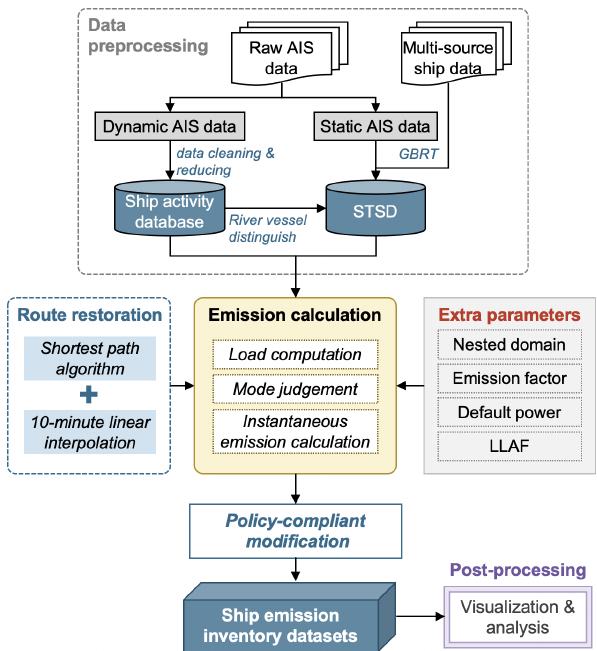
Figure 1. Structure and flow chart of the SEIM v2.0. The STSD stands for the ship technical specification database. The GBRT stands for the gradient boosting regression tree. The LLAF stands for the low load adjustment